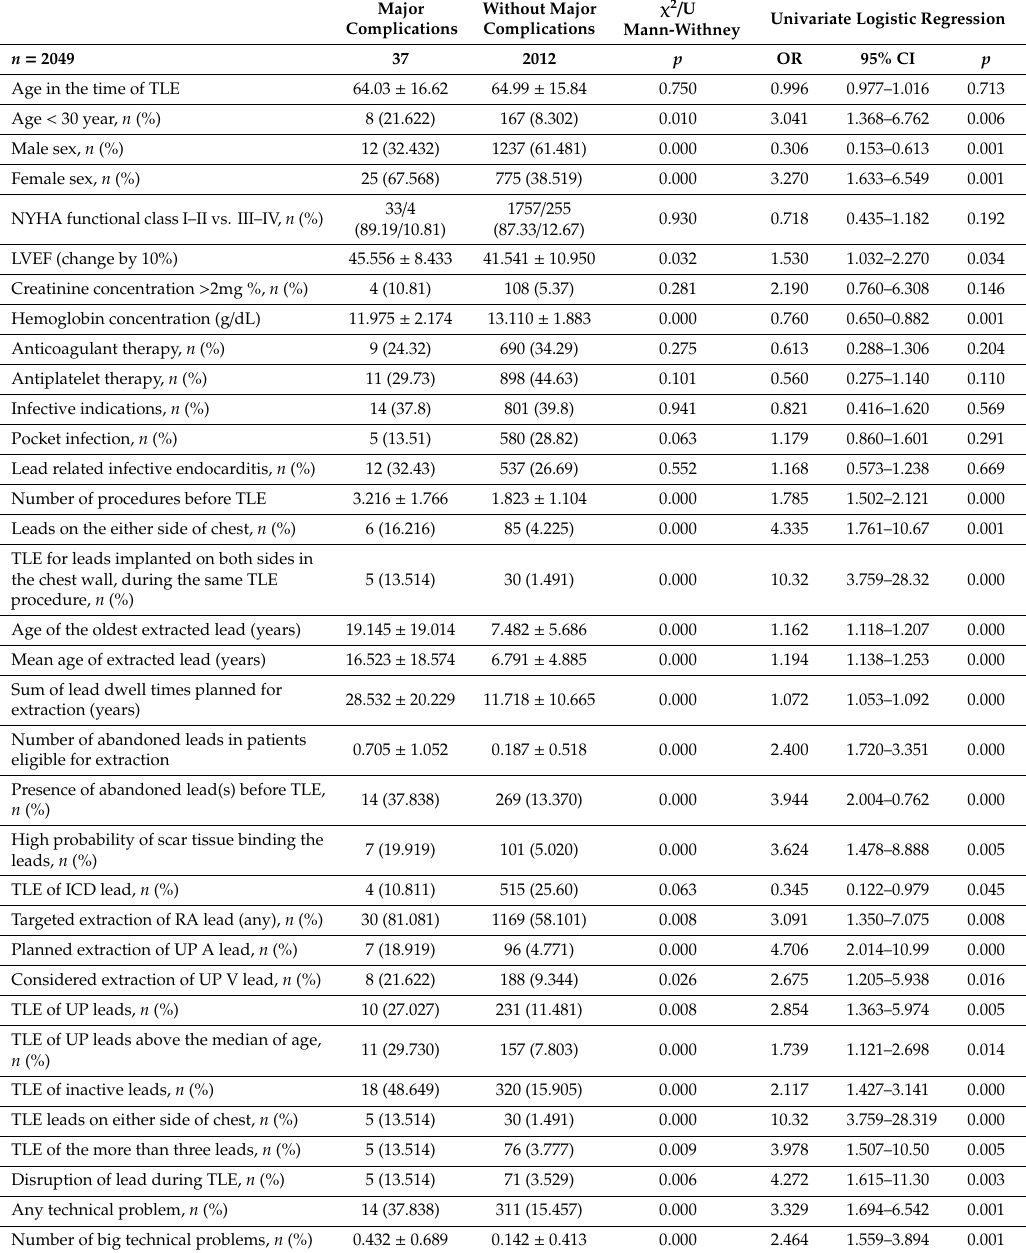
Table 1. Baseline characteristics of the study group depending on the occurrence of major complications during a TLE, along with a univariate logistic